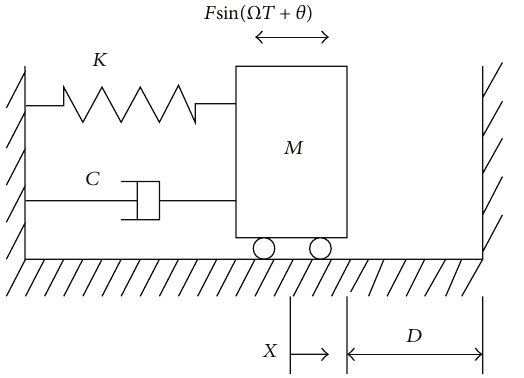
Figure 1: Mechanics model of a single-degree-of-freedom vibroim- pact